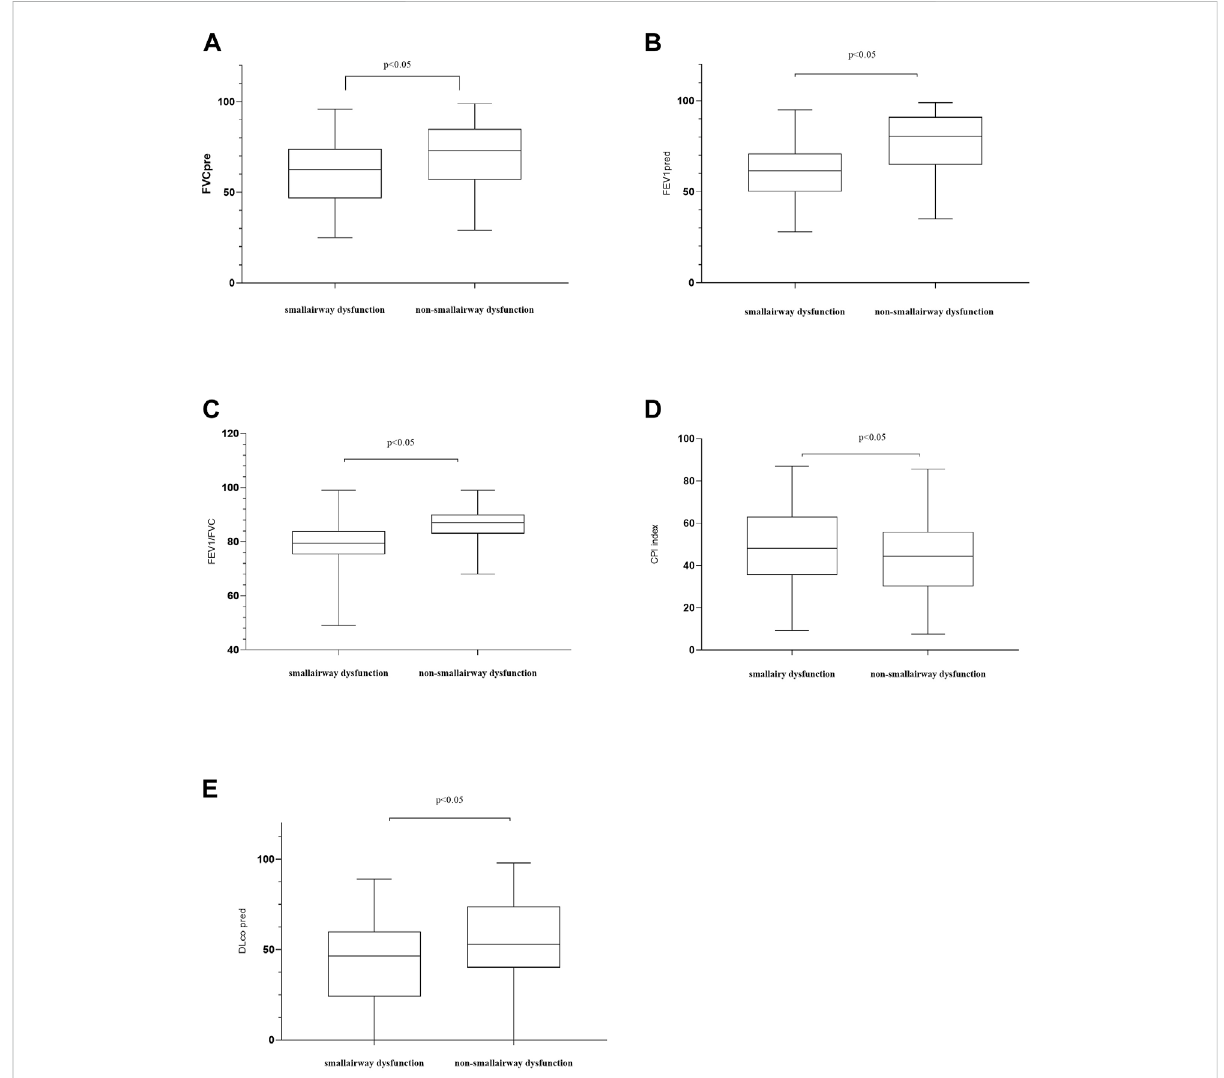
FIGURE 2 Comparisonsof patients ’ characteristics between theSADand non-SAD groups. (A) FVC, forced vital capacity. FVC pred:the percentageof the actualFVCoverthepredictedFVC; (B) forcedexpiratoryvolumein1 s(FEV1)%predicted; (C) FEV1/FVCratio; (D) CPI,compositephysiologicindex.In 2002,AtholU.Wells andothersproposed touse CPI,whichcombinedchestCTandpulmonaryfunctionalparameters,toassesstheseverity ofILDs. A higher CPI represents a more severe ILD; (E) DLco, diffusing lung capacity for carbon monoxide. DLco% pred, the percentage of the actual DLco over the predicted DLco; Moreover, p < 0.05 indicates statistical signi fi